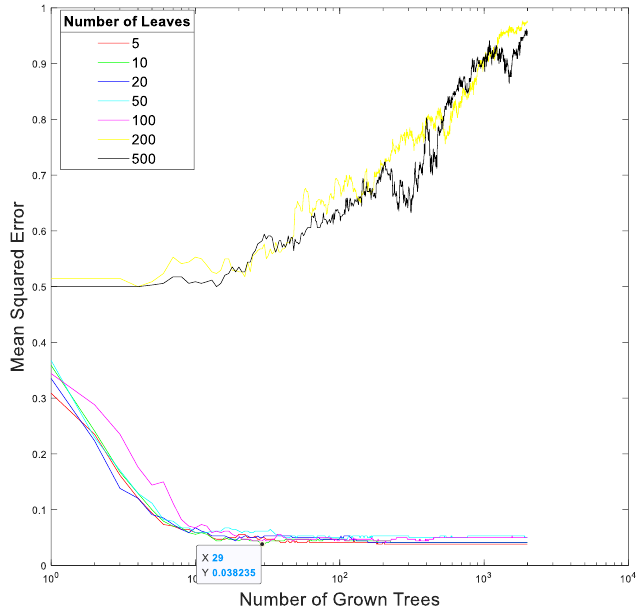
Figure 15. The relationship between the mean squares error and the total number of trees at different total numbers of leaf nodes in the random forest in our proposed method trained using the EEGs acquired from Hejian performing the reading activity under the concentration state on the first day.